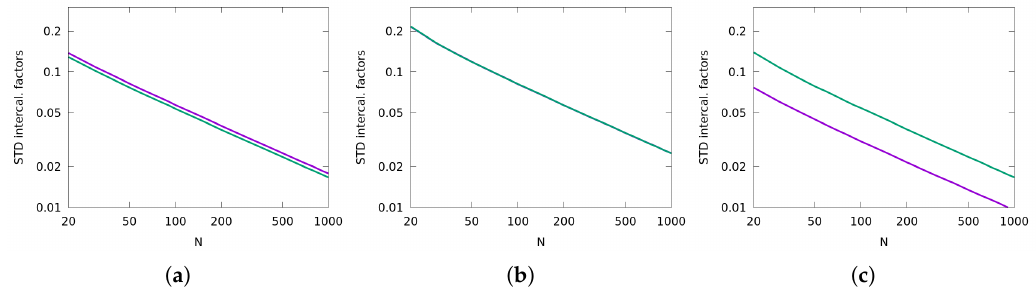
Figure 4. Log-log plot of the standard deviation of the intercalibration factors as a function of the sampling size N : purple represents the standard deviation of α 12 , and green represents the standard deviation of α 13 . ( a ) The results for case 1, ( b ) the results for case 2, and ( c ) the results for case